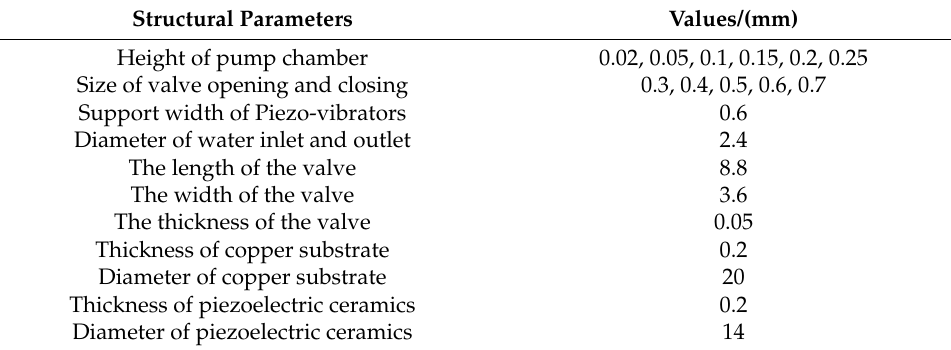
Table 1. Main structural parameters of piezoelectric